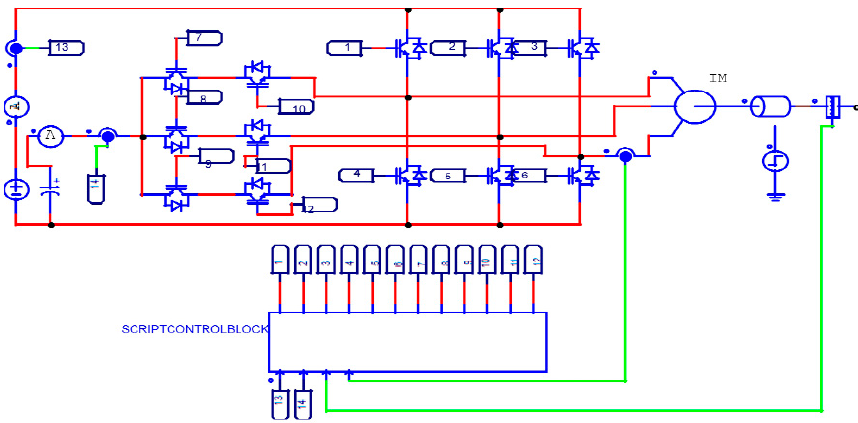
Figure 14. Simulation of a hybrid inverter with load (induction motor) [18,19].